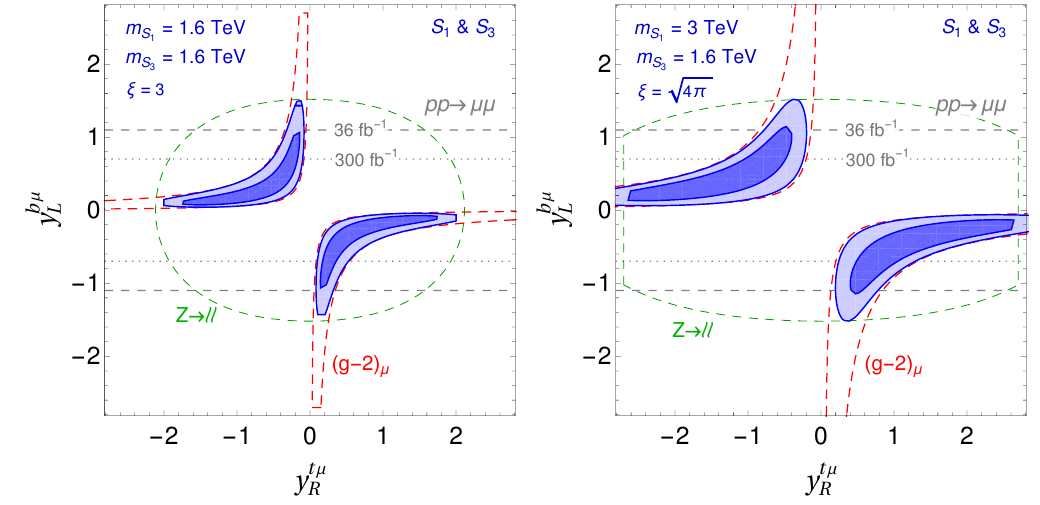
Figure 3 . The values of y t(cid:22) vs. y b(cid:22) for the S 1 & S 3 scenario that satisfy relevant flavor constraints R L and address ( g 2) (cid:22) through the top-quark loops are shown in dark (light) blue to 1 (cid:27) ( 2 (cid:27) ) accuracy (cid:0) for the mass degenerate case with (cid:24) = 3 and mass non-degenerate case with (cid:24) = p 4 (cid:25) in the left and right panels, respectively. The 2 (cid:27) constraints from the Z -pole observables and ( g represented with green and red dashed lines, respectively. The (projected) LHC limits from the study of pp (cid:22)(cid:22) at high- p T , at the 2 (cid:27) level, for ( 300 fb (cid:0) 1 ) 36 fb (cid:0) 1 worth of data are shown with ! (dash-dotted) dashed gray lines [35].